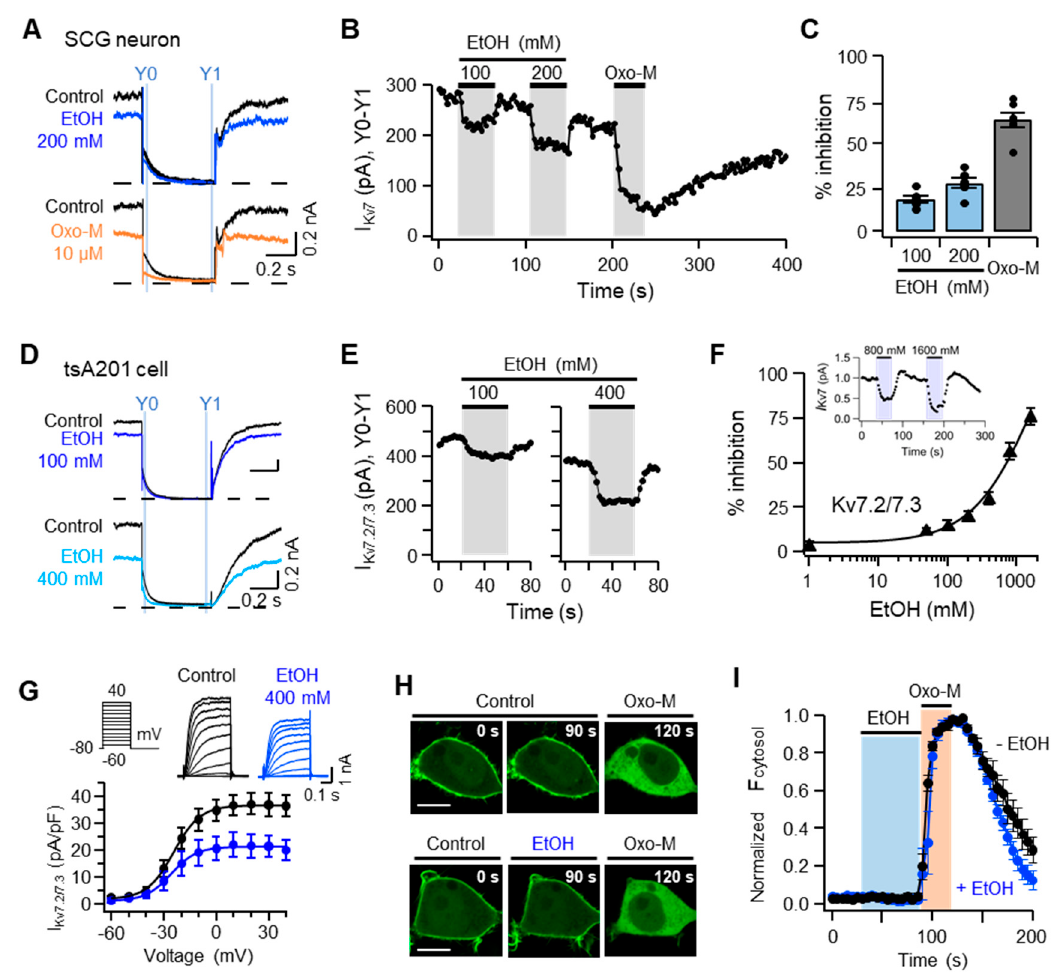
Figure 4. Ethanol inhibits Kv7 currents in superior cervical ganglia (SCG) neurons as well as in tsA201 cells transfected with Kv7.2 / 7.3. ( A ) Representative traces, showing Kv7 currents elicited in primary cultured SCG neurons using the protocol of − 20 to − 50 mV, while the cells were incubated with either 200 mM ethanol or 10 µ M Oxo-M. The dashed line indicates the zero-current level. ( B ) Time-course analysis of I Kv7 (Y 0 − Y 1 ) upon sequential treatments of 100 and 200 mM ethanol for 40 s each, followed by 10 µ M Oxo-M for 30 s. ( C ) Inhibition of Kv7 currents in primary cultured SCG neurons after treatment with ethanol or Oxo-M ( n = 6). ( D ) Representative traces, showing Kv7.2 / 7.3 currents elicited in tsA201 cells in the presence of ethanol (100 and 200 mM) or 10 µ M Oxo-M. ( E ) Time-course of Kv7.2 / 7.3 currents upon sequential treatments of 100 and 200 mM ethanol for 40 s each. ( F ) Dose-dependency, showing the inhibitory e ff ect of ethanol on the Kv7.2 / 7.3 current in tsA201 cells ( n = 5–9 for each dose). Cells were treated with 1, 50, 100, 200, 400, 800, or 1600 mM ethanol, and the inhibition of Kv7 current was measured. Inset, Time-course of Kv7 current regulation by 800 and 1600 mM ethanol. ( G ) Current-voltage relationship of Kv7.2 / 7.3 currents elicited in tsA201 cells using increasing voltage steps from − 60 mV to + 40 mV while the cells were untreated (black symbols, n = 4) or treated with 400 mM ethanol (blue symbols, n = 4). ( H ) Live confocal imaging showing intracellular localization of native fluorescence of pleckstrin homology domain of phospholipase C- δ 1 labeled with green fluorescence protein (PH(PLC δ 1)-GFP) within the tsA201 cells before and after treatment with 400 mM ethanol for 60 s, followed by 10 µ M Oxo-M for 30 s. Scale bars, 10 µ m. ( I ) Native fluorescence of PH(PLC δ 1)-GFP in the cytosolic compartment normalized by the maximum value of fluorescence obtained during Oxo-M treatment and the minimum in control ( n = 5 each).